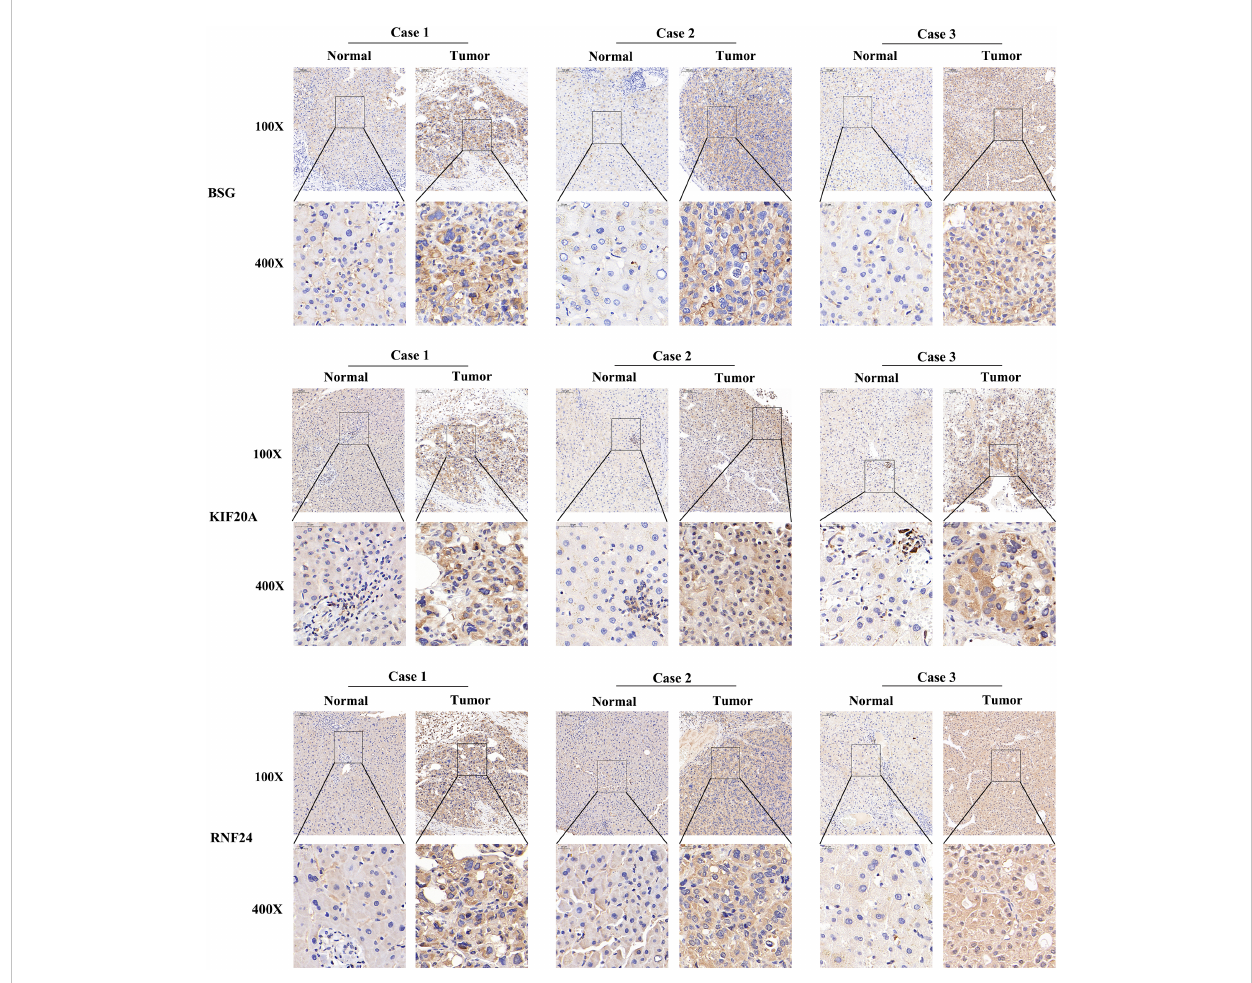
FIGURE 8 Immunohistochemistry of 3 signature genes in three pairs of HCC tissues and paraneoplastic tissues.